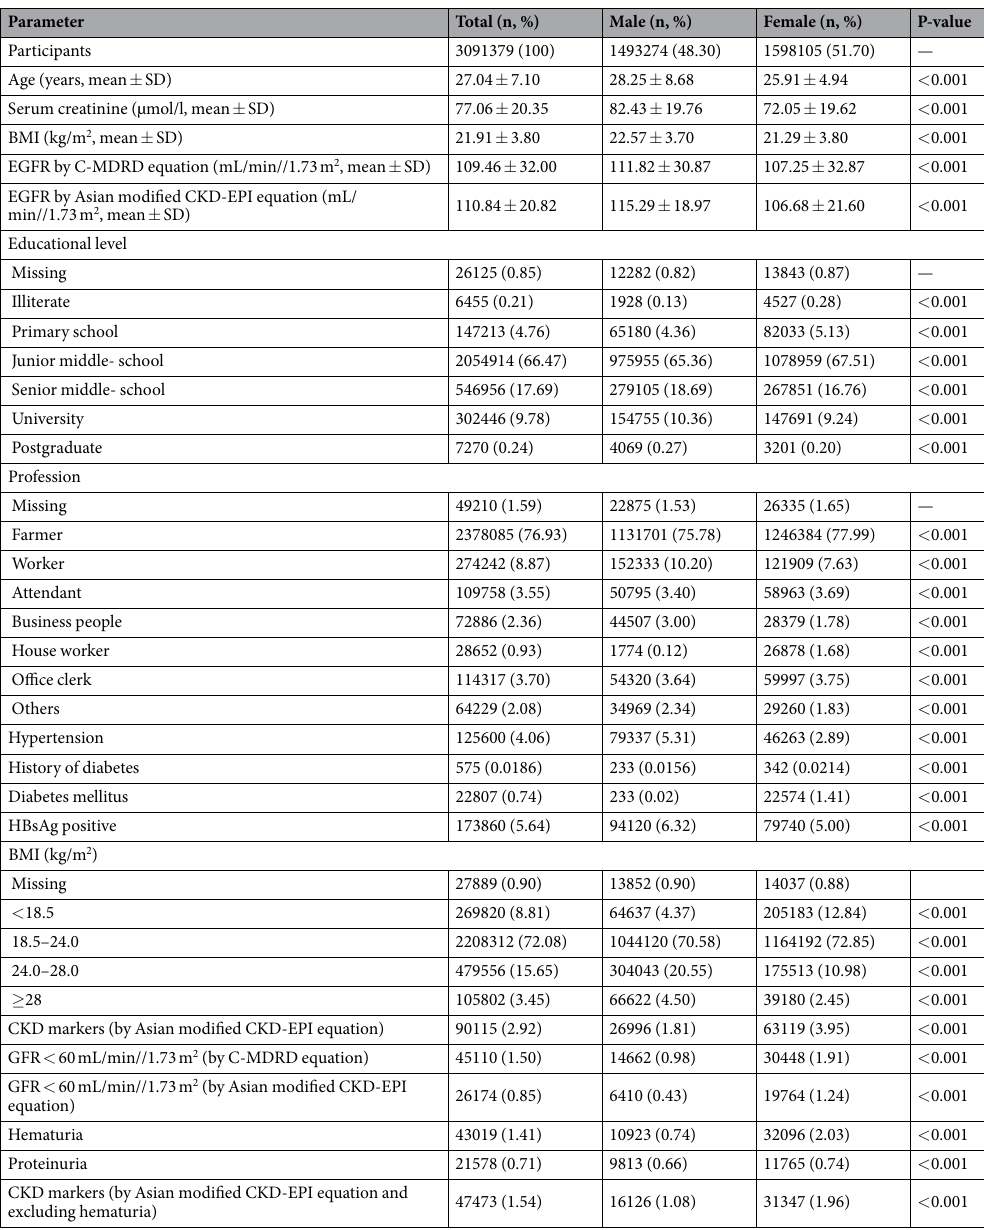
Table 1. Sociodemographic and clinical characteristics of the married population with fertility desire in rural China. CKD: chronic kidney disease. eGFR: estimated glomerular filtration rate. HBsAg: hepatitis B virus surface antigen. BMI: body-mass index. C-MDRD equation: Chinese modification of diet in renal disease equation. CKD-EPI equation: chronic kidney disease epidemiology collaboration equation. SD: standard